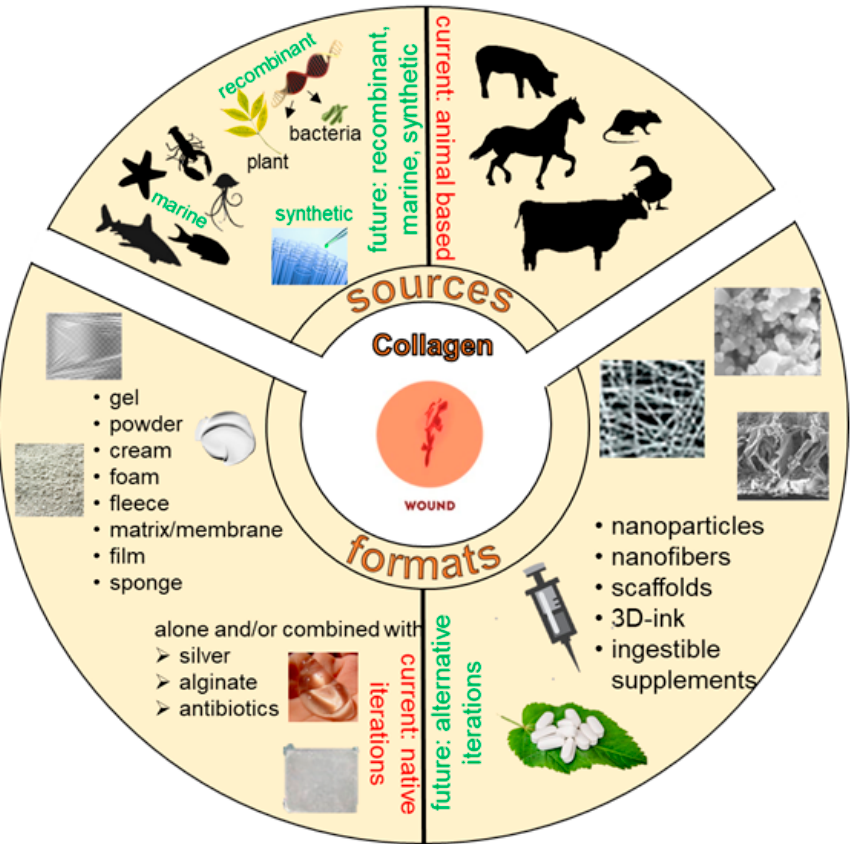
Figure 2. Sources and formats of collagen for wound healing applications.